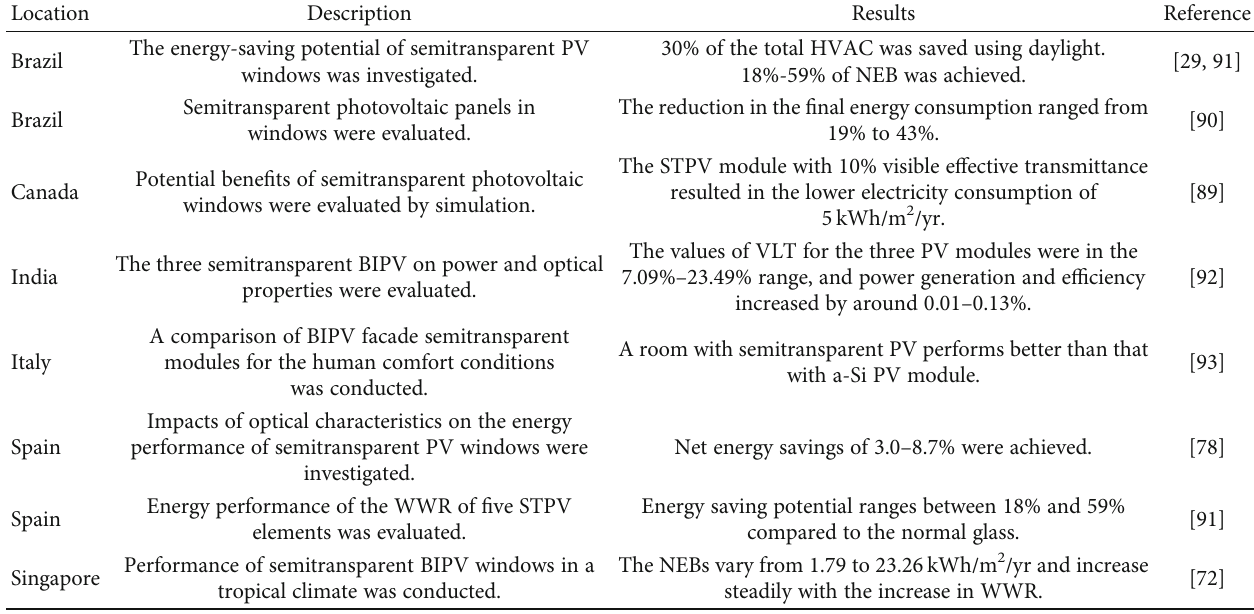
Table 5: Electrical and optical properties of semitransparent BIPV: case studies from di ff erent locations. Location